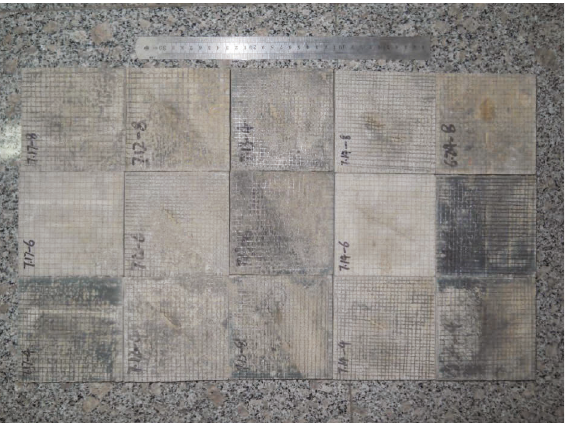
Figure 4: Test condition 2.